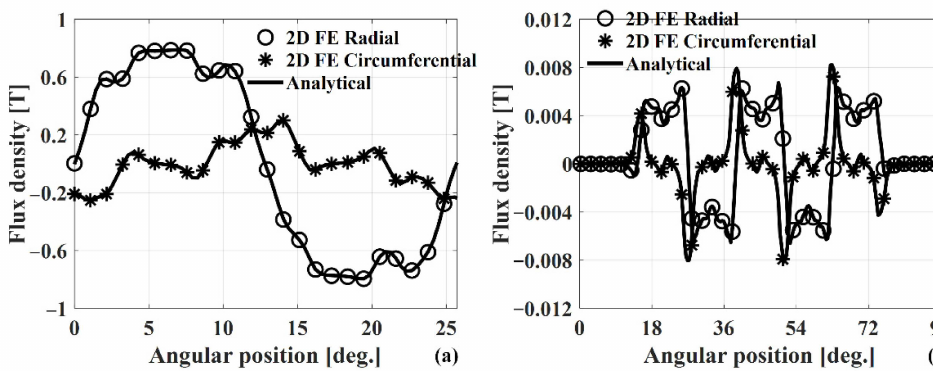
Figure 4. Magnetic flux density distributions due to ( a ) PMs and ( b ) armature coils.